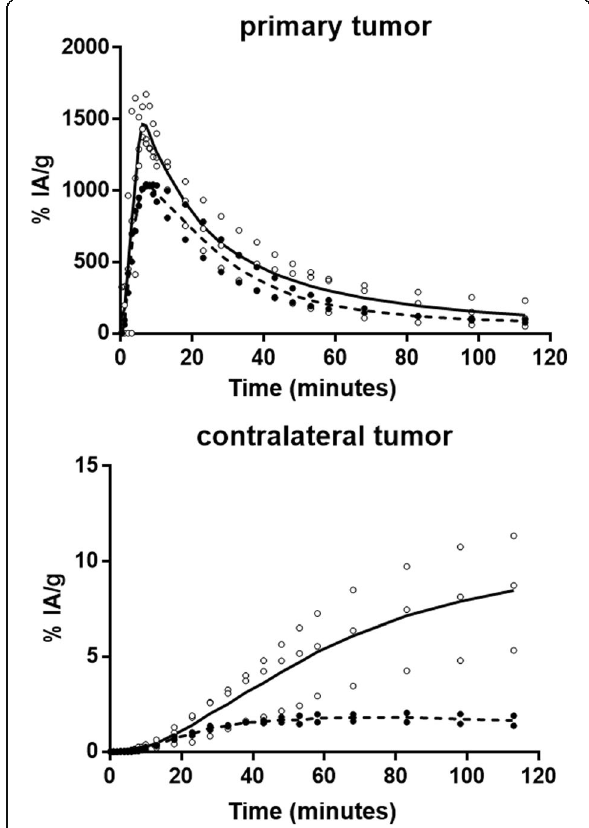
Fig. 2 Tumor uptake and clearance of 18 F-FLT (solid line) and 18 F-FDG (dashed line) in mice bearing HCT116 human colorectal tumors after i.t. infusion of 5MBq into the left rear flank tumor. The radiotracer kinetics was measured during 2h by dynamic PET imaging. Data are expressed as the percent injected activity per gram for tissue (%IA/g). All data were corrected for physical decay of the